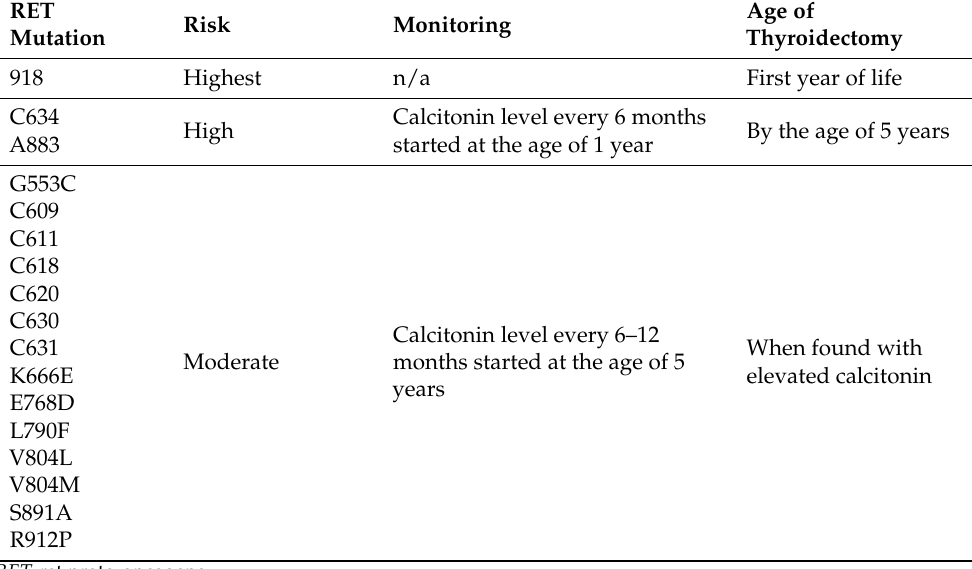
Table 5. RET oncogene mutation and risk categorization. RET Risk Mutation